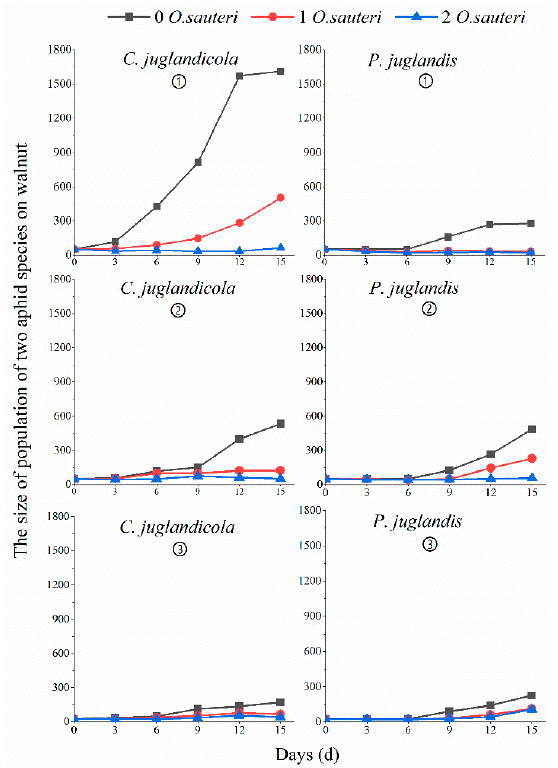
Figure 1. The mean number of aphids in populations of two aphid species exposed to an initial density of 0, 1, and 2 O. sauteri predatory bugs over 15 days. Note: ① indicates the laboratory experiments, ② indicates the field experiments, ③ indicates the mix population experiments. The populations of P. juglandis , as well as C. juglandicola, declined after 15 days if treated with predators. The mean control efficacy of P. juglandis were 79% ± 8.7%